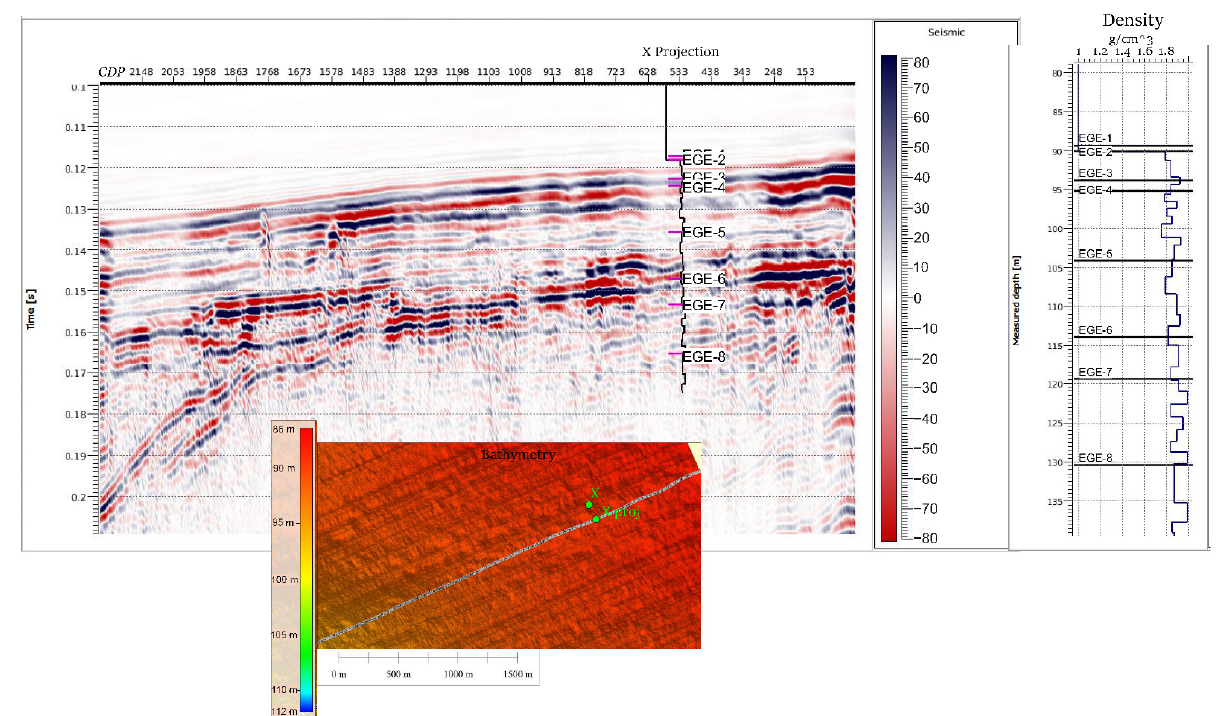
Figure 1. The 2D seismic profile along the project well (X-proj is the projection of the engineering well X). The 1D model of the bulk density measured in the laboratory for the well X is shown on the seismic profile and on the right.